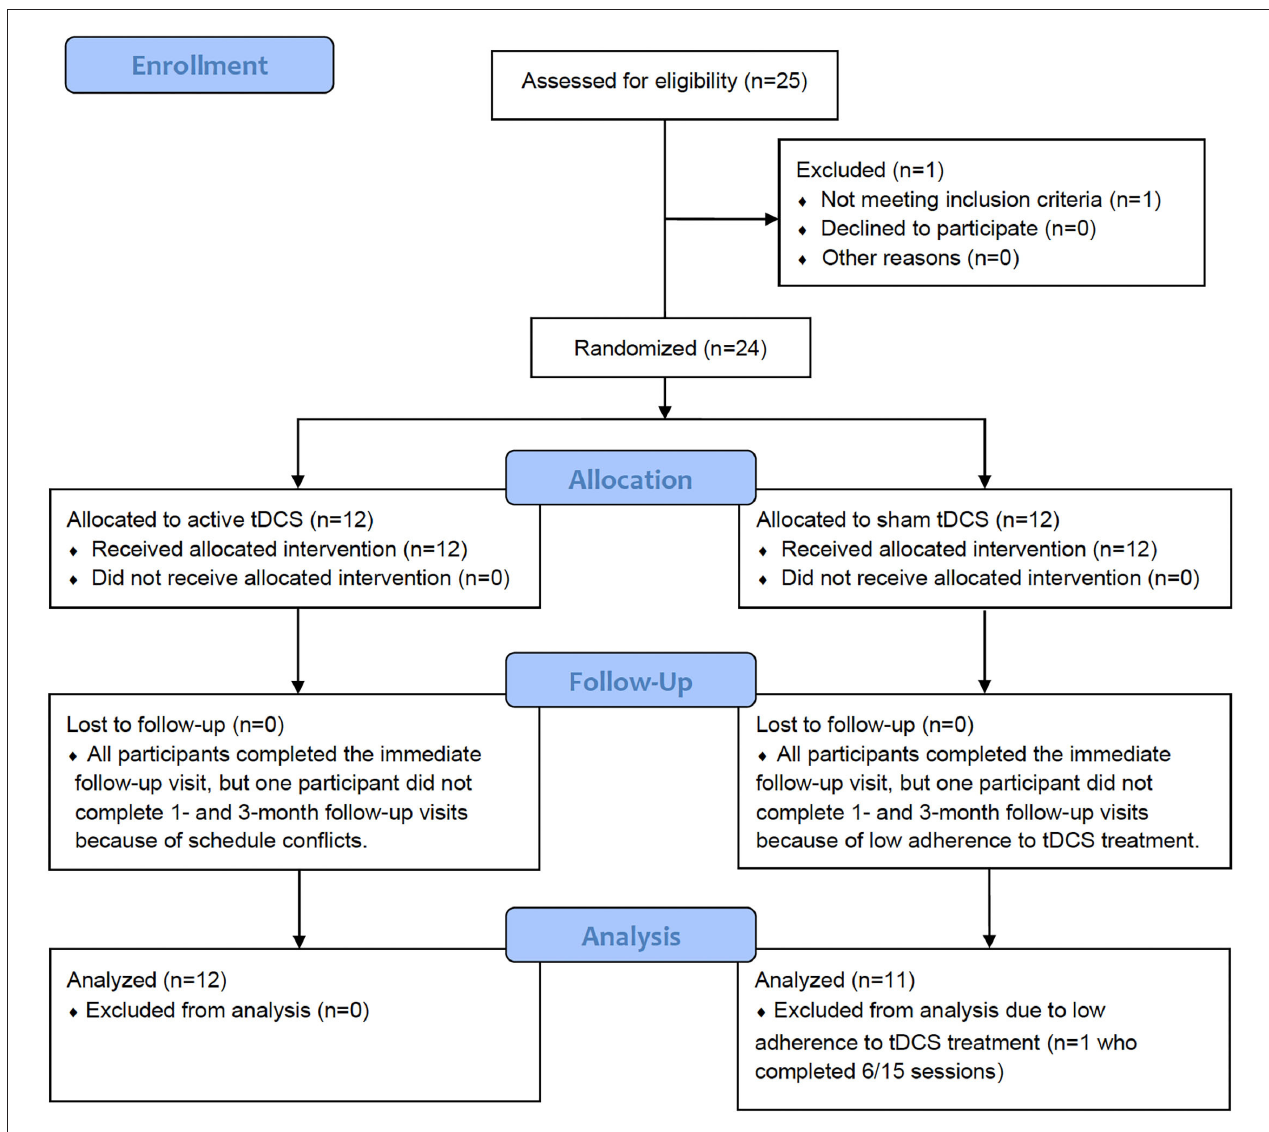
FIGURE 1 | Flow diagram for study